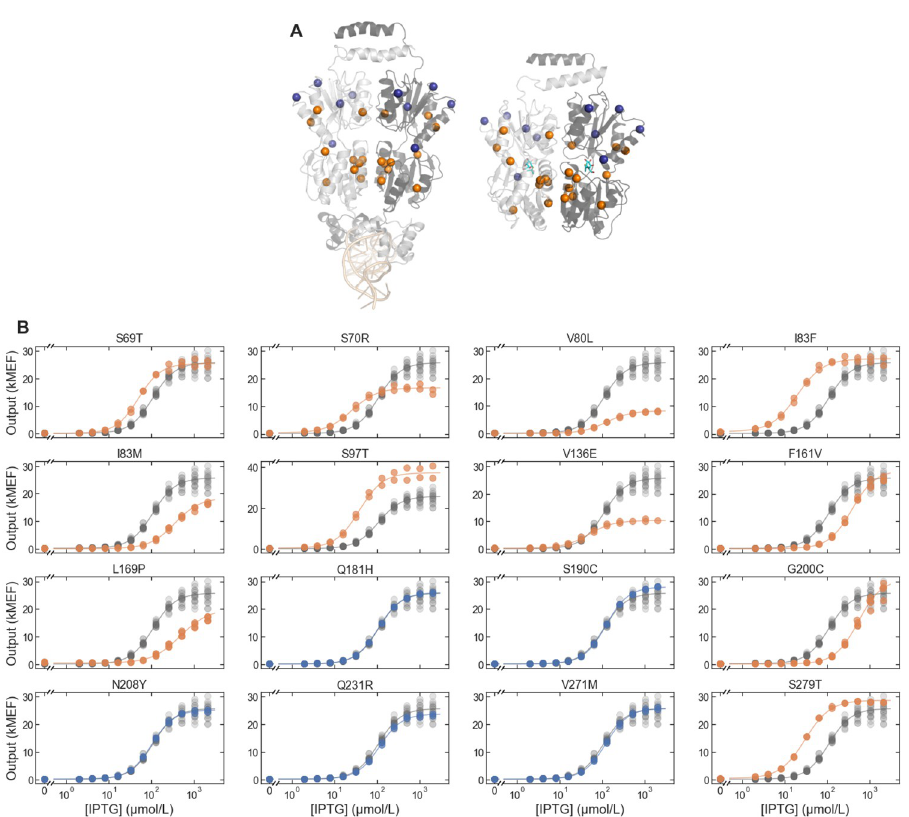
Fig 7. Mutations used for ML-enabled forward engineering. (A) LacI protein structure showing location of mutations. The DNA-binding configuration is shown on the left (DNA at the bottom of the structure in light orange, PDB ID: 1LBG [30]) and the ligand-binding configuration is shown on the right (IPTG in cyan, PDB ID: 1LBH [30]). Both configurations are shown with the view oriented along the protein dimer interface, with one monomer in light gray and the other monomer in dark gray. Colored spheres highlight the positions of mutations used for ML-enabled forward engineering, with silent mutations in blue and non-silent mutations in orange. (B) Dose-response of single- mutant LacI variants with each of the mutations used for ML-enabled forward engineering. In each plot, the single- mutant dose-response is plotted in blue (for silent mutations) or orange (for non-silent mutations), and the wild-type dose response is plotted in